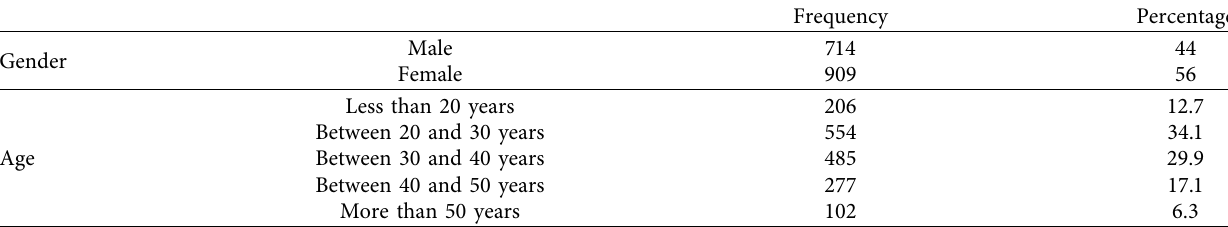
Table 2: The frequency of mucous retention cysts (MRCs in the population, n � 1624) discriminated by age group. Age